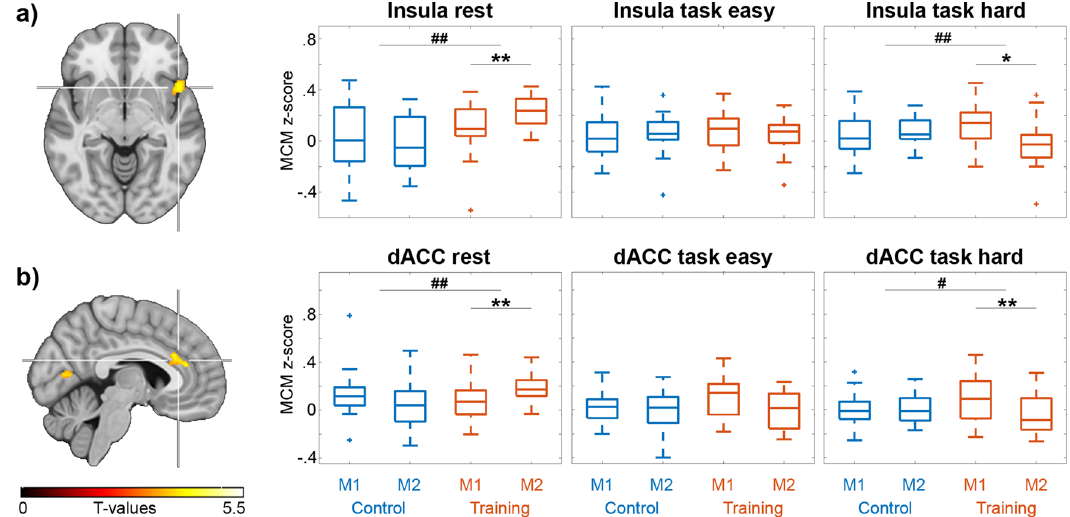
Fig. 3 Learning-induced changes in metabolic connectivity mapping (MCM) with the occipital cortex as target region. Four weeks of training the video game Tetris ® resulted in speci fi c adaptations of connectivity from the right insula ( a ) and the dorsal anterior cingulate cortex (dACC, b ) to the occipital cortex (group*time*condition interaction, p < 0.05 FWE-corrected cluster level). Post-hoc comparisons showed that at rest MCM increased for both connections in the training group ( n = 21) as compared to the control group ( n = 20). In contrast, MCM decreased during the hard task condition in the training group. There were no signi fi cant changes in the control group between the two measurements (M1, M2). Furthermore, MCM values between training and control groups at measurement 1 were not signi fi cantly different. Boxplots show the MCM z-scores of the clusters indicated by the crosshair.